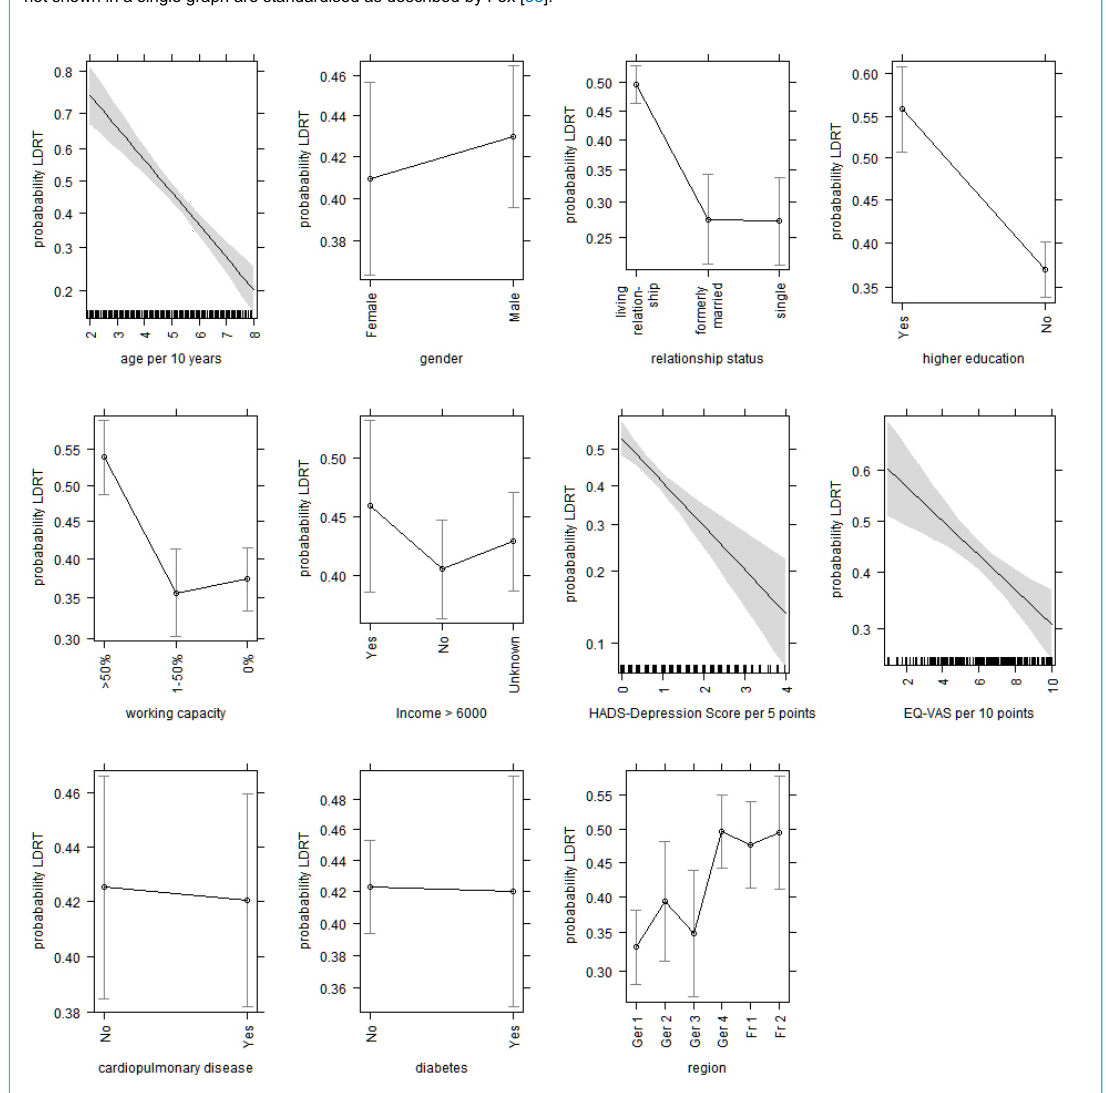
Figure S2: Effect plots for the estimates of the covariates of the logistic regression for outcome live donor renal transplant (LDRT). Covariates not shown in a single graph are standardised as described by Fox